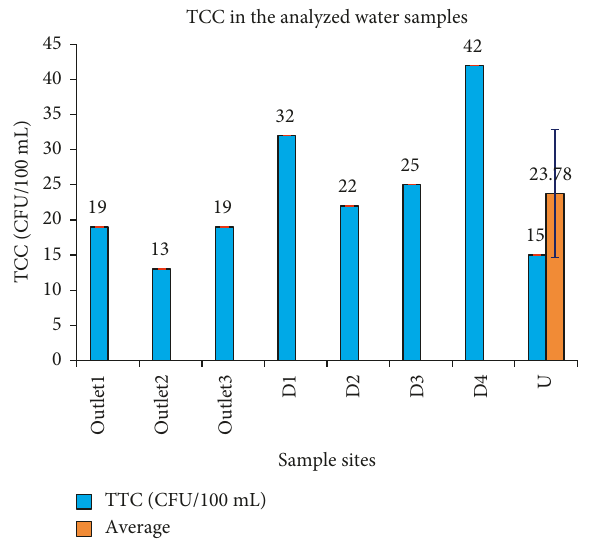
Figure 10: The level of thermotolerant bacteria in the analyzed wastewater samples.